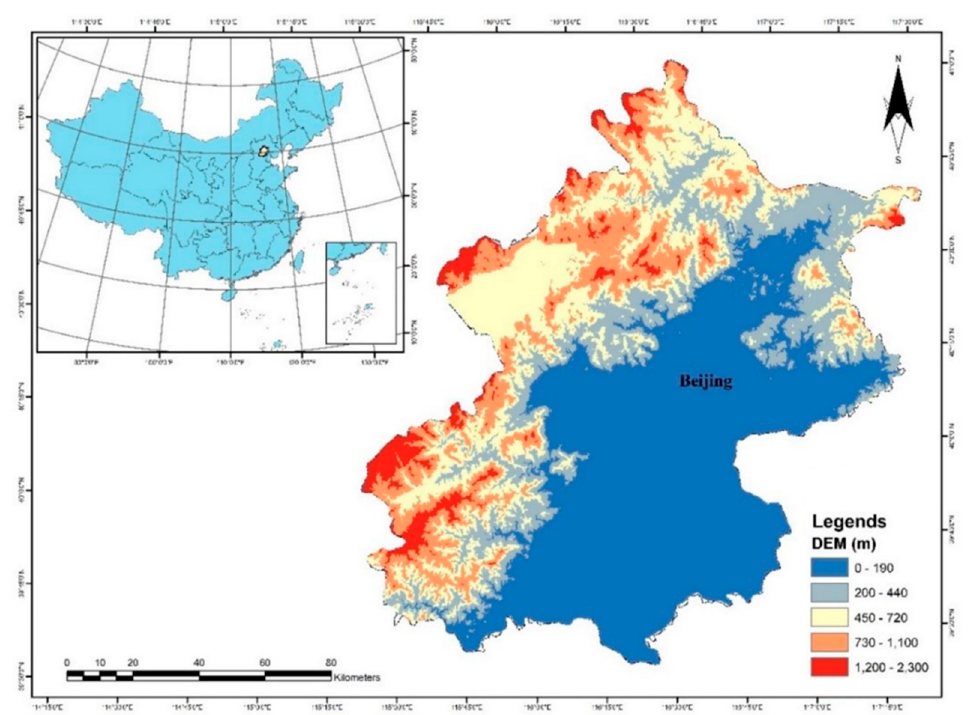
Figure 1. This map shows the geographical overview of the study area. On the left hand, the map represents the ancillary data and digital elevation model (DEM). This map was generated by using ArcGIS 10.7.